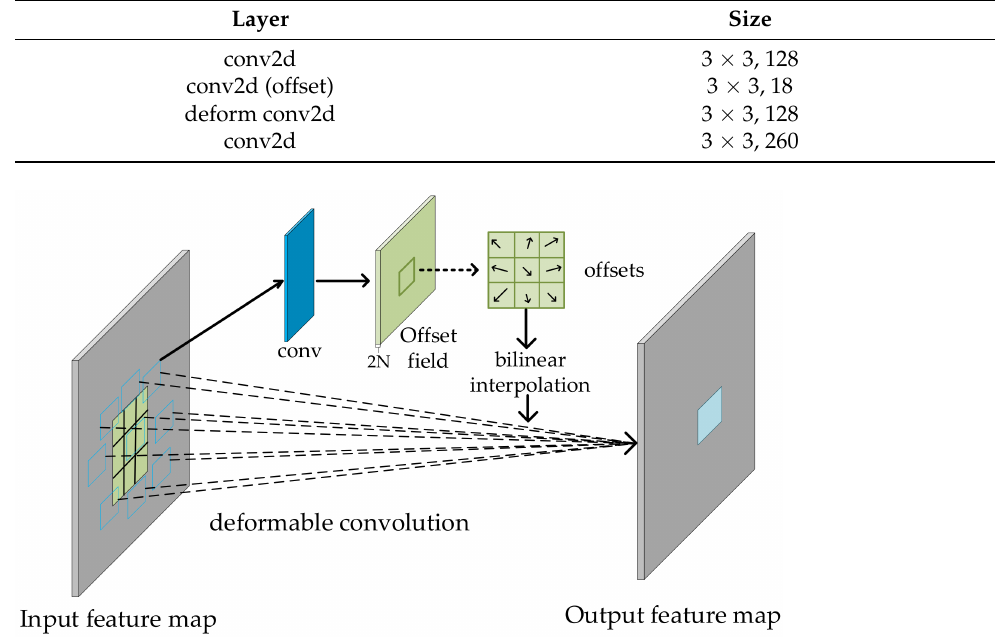
Table 1. Parameter settings of the DCR block of the residual part.